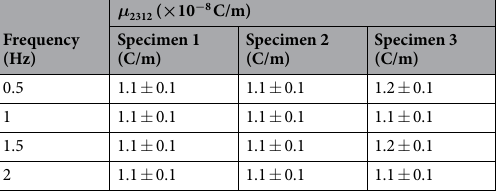
Table 2. Measured values of flexoelectric coefficient component μ 2312 of